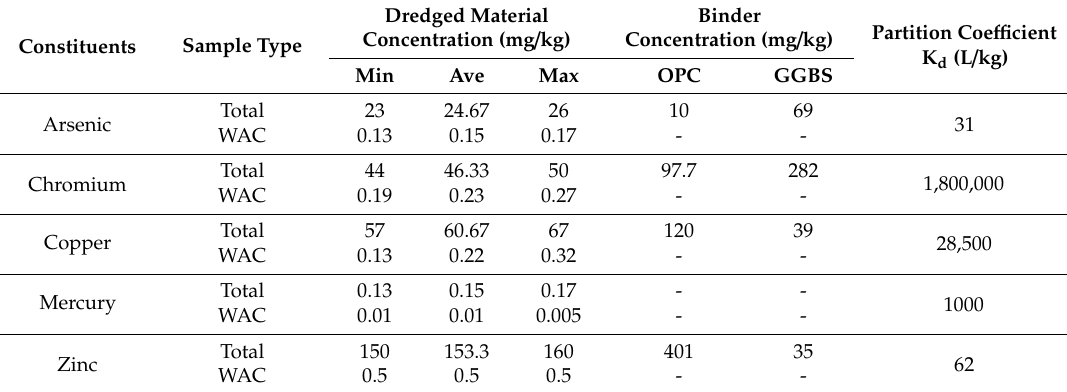
Table 4. Comparison of binder and dredged material concentrations.